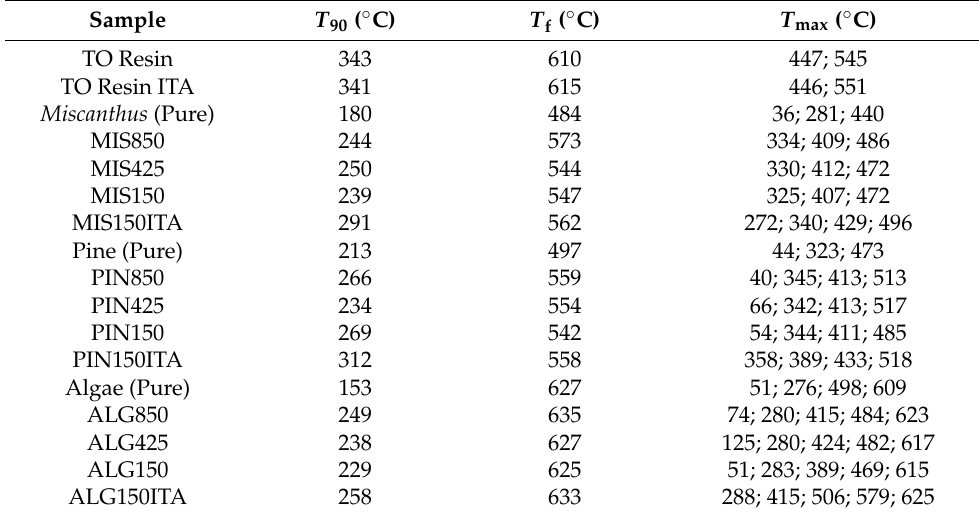
Table 2. T 90 , T f and T max for resins and